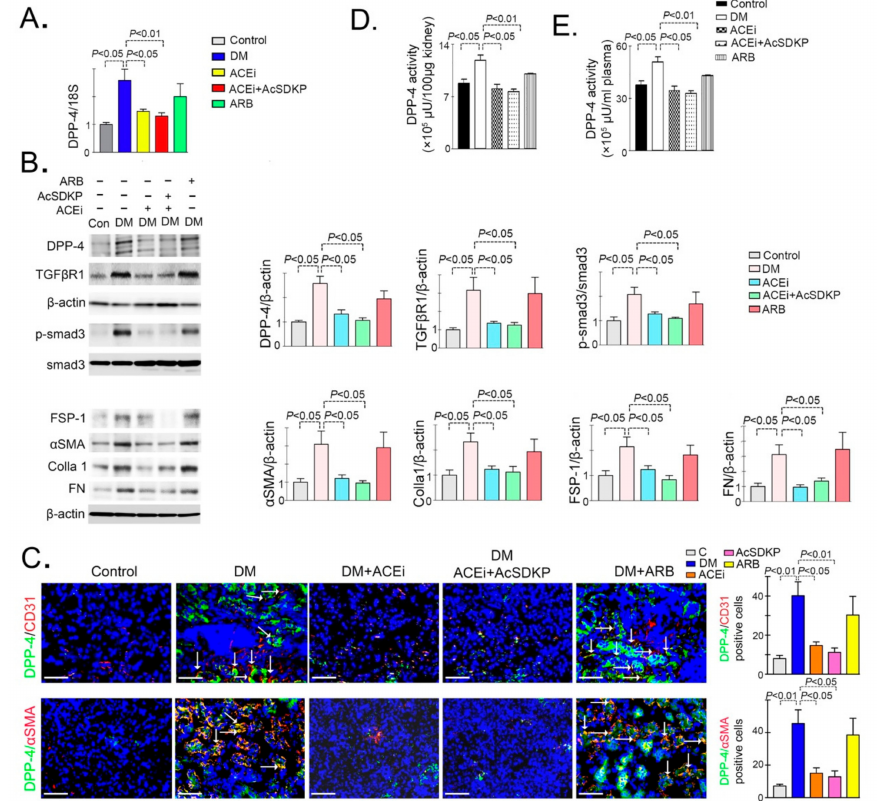
Figure 1. Inhibition of ACE suppresses DPP-4 and associated TGF β signaling in diabetic kidneys ( A ) Quantitative analysis of DPP-4 mRNA expression by real time PCR using specific primers in the kidney of control, DM, DM + ACEi, DM + combination and DM + ARB treated mice. N = 6 were analyzed in each group. 18S was used as internal control to normalize the expression data. ( B ) Western blot analysis of DPP-4, TGF β R1, p-smad3, smad3, FSP-1, α SMA, Colla1a and fibronectin (FN) in the kidney of control, DM, DM + ACEi, DM + combination treatment and DM + ARB treated diabetic mice. Representative blots are shown. Quantification of DPP-4, TGF β R1, smad3 phosphorylation,